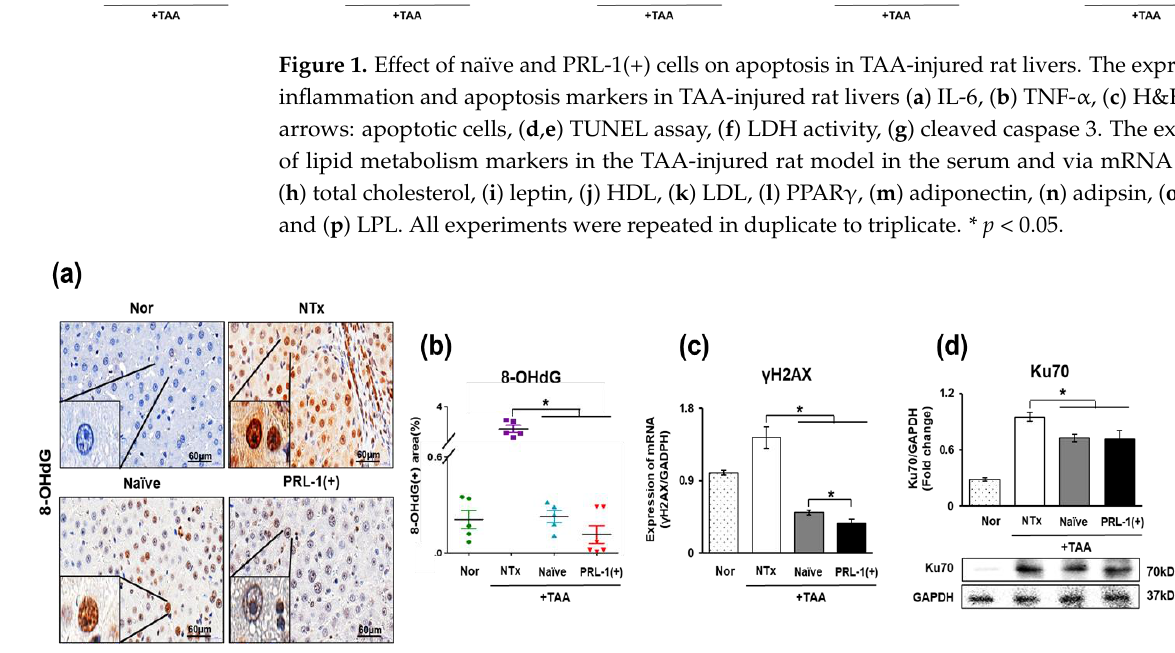
Figure 2. Effects of naïve and PRL-1(+) DNA repair systems in TAA-injured rat livers. The expres- sion of DNA damage and repair markers in TAA-injured rat livers by IHC, mRNA level and protein level. ( a , b ) 8-OHdG, ( c ) γ H2AX, and ( d ) Ku70. All experiments were repeated in duplicate to triplicate. * p < 0.05.